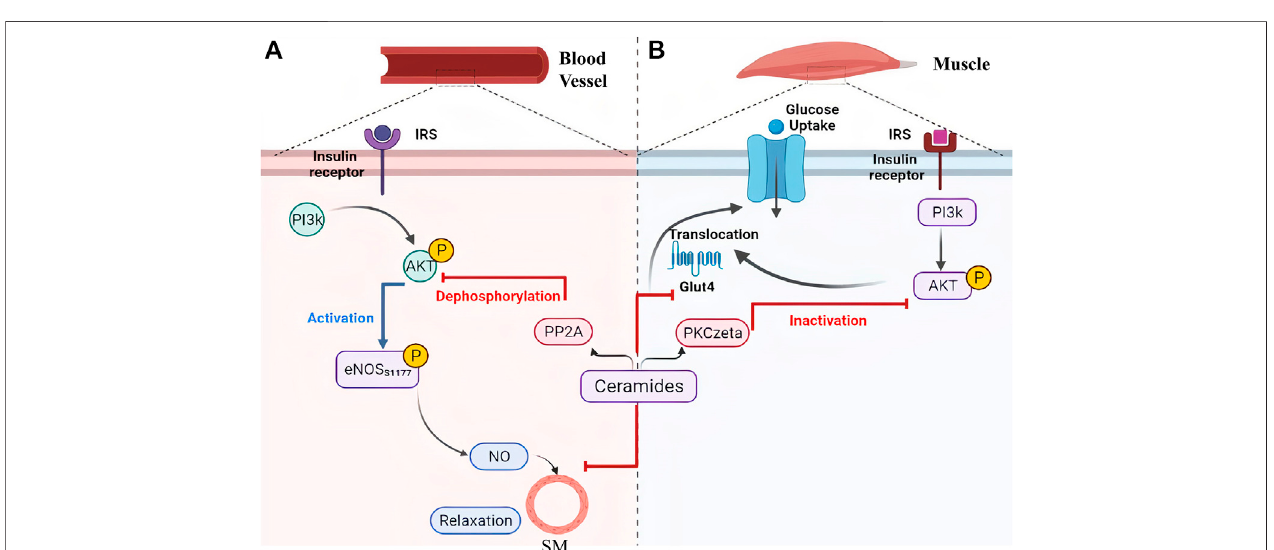
FIGURE 5 | Ceramides contribute to metabolic disorders via inhibition of PI3k/Akt as a common pathway between vasoconstriction and insulin resistance. Ceramides can facilitate the inactivation of protein kinase B (AKT) through (A) its dephosphorylation by protein phosphatase 2A or (B) binding to the inhibitor PKCzeta proteinwhichleadstonarrowingofbloodvesselsandinhibitionofglucosetransporter4translocation(glucoseintolerance),respectively.[eNOS,EndothelialNitricOxide Synthase; Glut 4, Glucose Transporter 4; IRS, Insulin Receptor Substrate; NO, Nitric Oxide; PI3k, Phosphoinositide-3-kinase; PKCzeta, Protein kinase C zeta; PP2A, Protein Phosphatase 2A; SM, Smooth Muscles]. This illustration was created with Biorender.com.